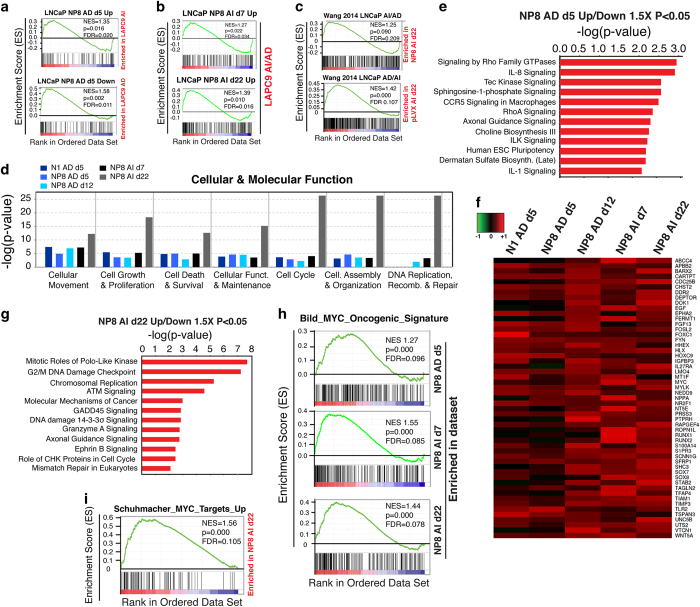
NANOG upregulates cell motility genes and engages oncogenic MYC. (a–c) GSEA showing that NP8 upregulated genes at AD d5 (a, top) or AI d7 and d22 (b) were all enriched in LAPC9 AI tumors. In contrast, NP8 downregulated genes at AD d5 were enriched in LAPC9 AD tumors (a, bottom). Reciprocally, the LNCaP AI-Up genes were enriched in the NP8 AI d22 cells, whereas LNCaP AD-Up genes were enriched in the control (pLVX) AI d22 cells (c). (d) IPA Biological Processes analysis of NANOG-induced DEGs (both up/down >1.5× and P<0.05) under indicated five conditions. Presented are the major ‘Cellular & Molecular Functions’ enriched in each condition. (e) IPA Canonical Pathway analysis of DEGs (both up/down >1.5× and P<0.05) under AD d5 in response to NP8 overexpression. (f) Heatmap of the 53 migration-related genes (from Supplementary Figure S7G; presented here alphabetically) persistently induced by NANOG expression. (g) IPA Canonical Pathway analysis of DEGs (both up/down >1.5× and P<0.05) in AI d22 cells. (h, i) GSEA showing the MYC oncogenic signature (h) and MYC target genes (i) are enriched in both NP8 AD and AI LNCaP cells.